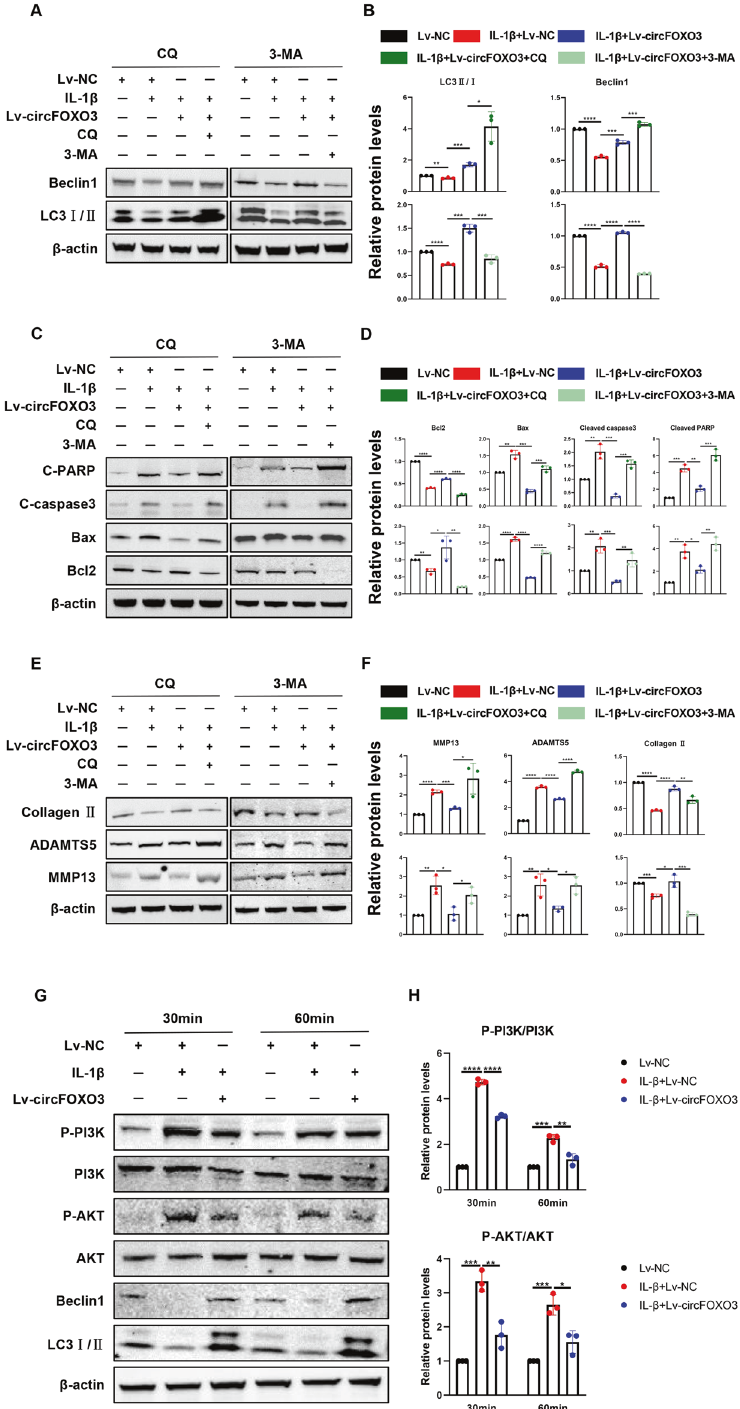
Fig. 6 CircFOXO3 autophagy sensitively regulates IL-1 β -induced ATDC5 chondrocyte arthritis phenotype. A Representative Western blot of Beclin1 and LC3 in ATDC5 chondrocytes pretreated with Lv-circFOXO3 with or without IL-1 β (10 ng/mL) in the presence or absence of CQ (50 μ M) or 3-MA (5 mM) for 24 h. B quantitative analysis of the protein levels in Fig. 7B. (n = 3) * p < 0.05, ** p < 0.01, *** p < 0.001, **** p < 0.0001. C Representative Western blot of Cleaved PARP, Cleaved caspase-3, Bax and Bcl2 in ATDC5 chondrocytes pretreated with Lv-circFOXO3 with or without IL-1 β (10 ng/mL) in the presence or absence of CQ (50 μ M) or 3-MA (5 mM) for 24 h. D quantitative analysis of the protein levels in Fig. 7D. ( n = 3) * p < 0.05, ** p < 0.01, *** p < 0.001, **** p < 0.0001. E Representative Western blot of MMP13, ADAMTS5 and Collagen II in ATDC5 chondrocytes pretreated with Lv-circFOXO3 with or without IL-1 β (10 ng/mL) in the presence or absence of CQ (50 μ M) or 3-MA (5 mM) for 24 h. F quantitative analysis of the protein levels in Fig. 7F. ( n = 3) * p < 0.05, ** p < 0.01, *** p < 0.001, **** p < 0.0001. G PI3K/AKT, Phosphorylation of PI3K/AKT and Beclin1, LC3 in ATDC5 chondrocytes infected with Lv-circFOXO3 with or without IL-1 β (10 ng/mL) for different time span. H Quantitative analysis of the protein levels in Figure 8B. ( n = 3) * p < 0.05, ** p < 0.01, *** p < 0.001, **** p < 0.0001.